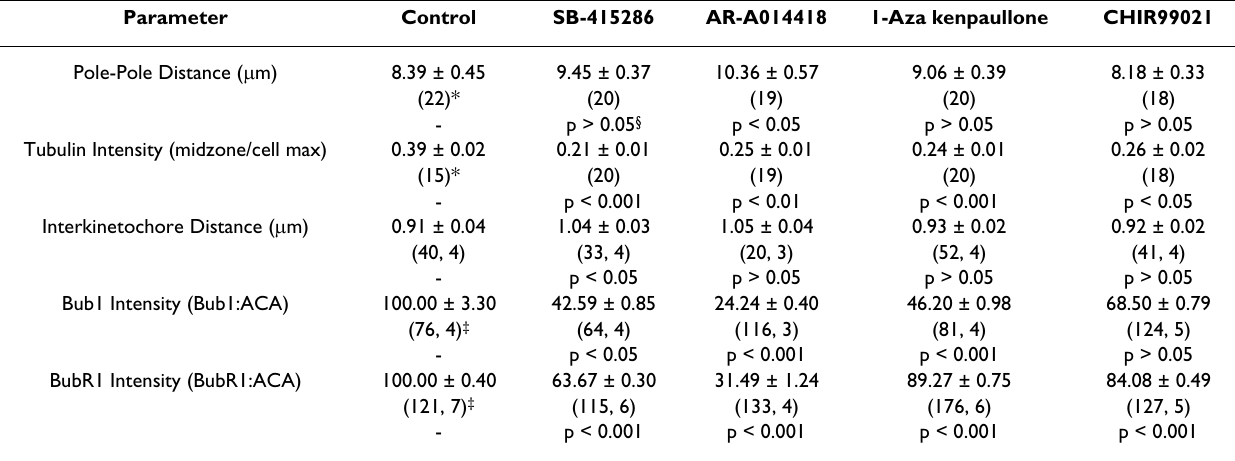
Table 4: Effect of GSK-3 inhibitors on spindle morphology